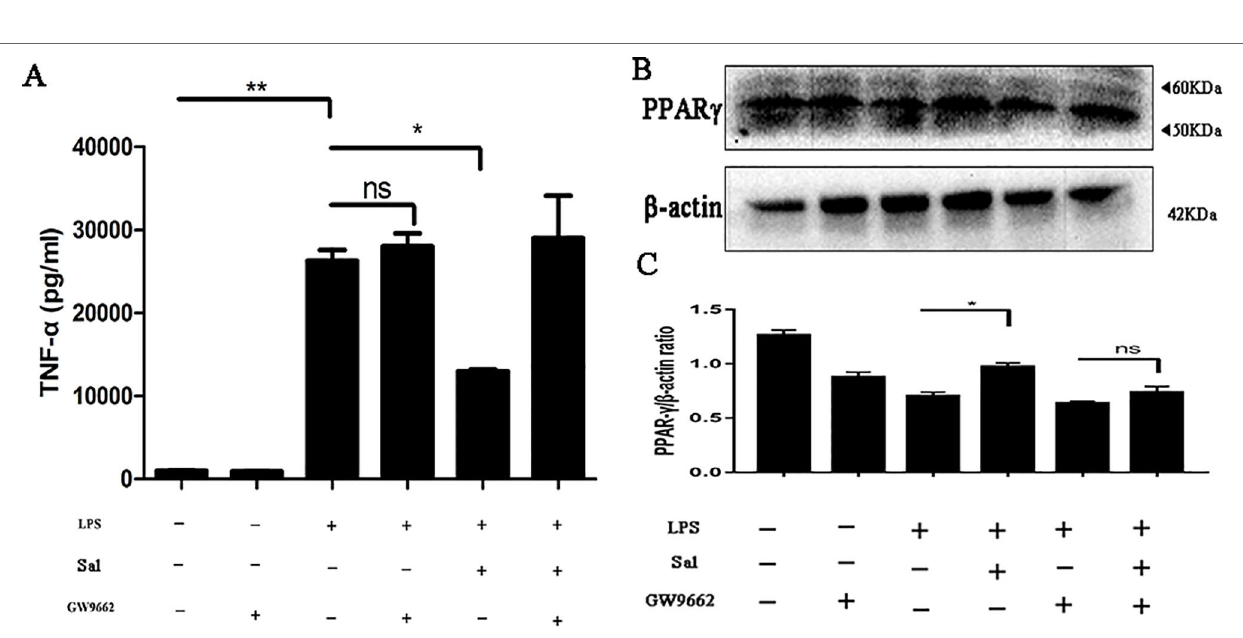
Frontiers in Pharmacology |